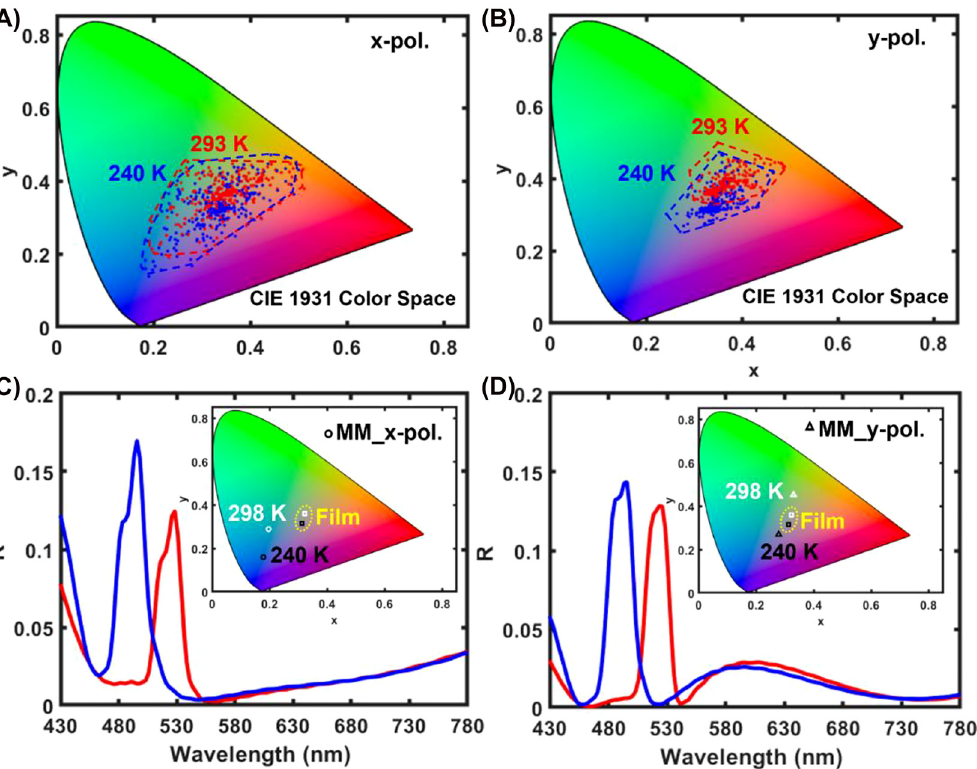
PbI nanograting metasurface. Figure 3: Large gamut and switching of colors with a BA 2 4 (A and B) Small changes in the geometrical parameters of the nanogratings, such as gap size ( g = 50–200 nm), beam width ( w = = 0–240 nm) allow to access a large color gamut under, respectively, x -polarized and y -polarized incident 50–350 nm) and milling depth ( t m PbI perovskite film. (C and D) Numerically calculated reflection light, thus significantly expanding on the color of the unpatterned BA 2 4 PbI perovskite metasurfaces under, respectively, x -polarized and y -polarized incident light, which show a large spectra of two BA 2 4 dynamically controllable color contrast variations of the temperature between 293 and 240 K.